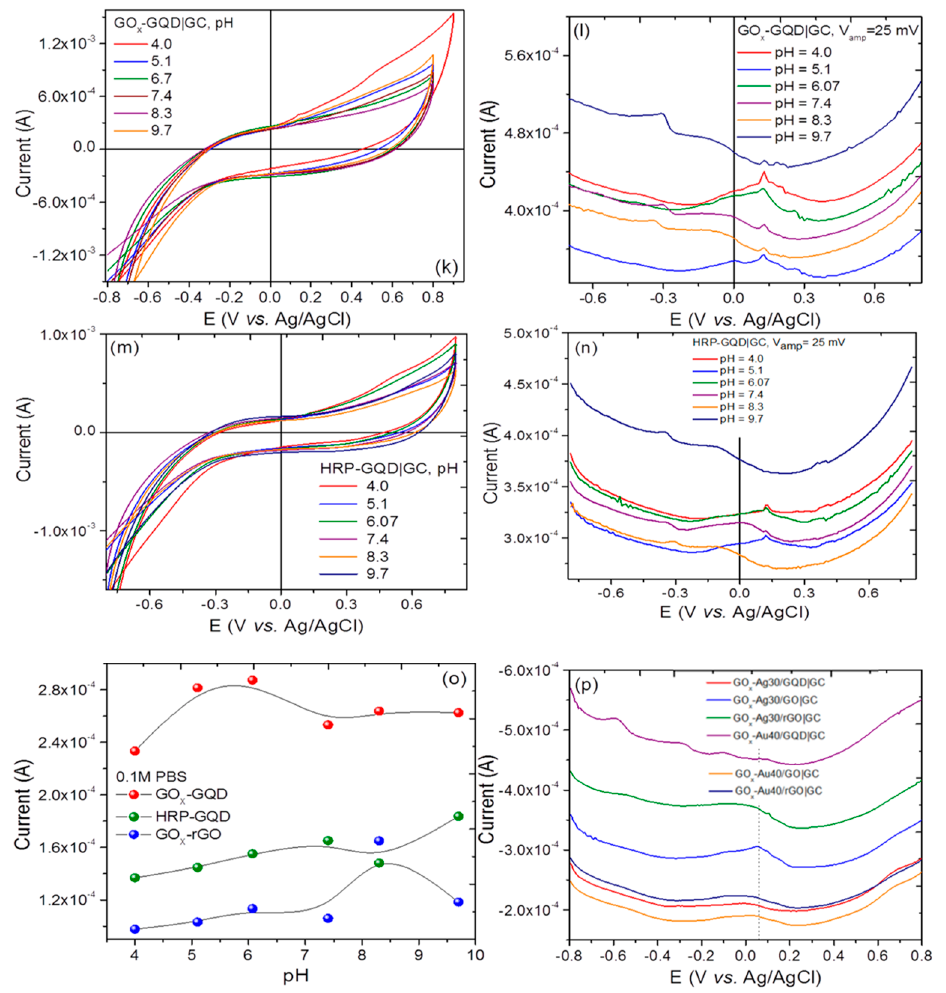
Figure 3. Cyclic voltammograms (CVs) of GQD immobilized on glassy carbon-GQD|GC with scan rate (10, 50 and 100 mV/s) in ( a ) in 0.1 M PBS (phosphate buffer solution) electrolyte pH 7.4 ( b ) in 0.1 M PBS electrolyte with 5 mM FcMeOH ( c ) variation of peak current with scan rate square root. ( d , f ) CV profiles and ( e , g , h ) variation of current with scan rate and square root scan rate (5, 10, 20, 50,100, 200, 300, 400 and 500 mV/s) in 0.1 M PBS and at 10 mV/s with 40 µ M H 2 O 2 adsorbed on GQD|GC and GQD|GC, respectively. Also shown are ( i ) CV profiles and ( j ) variation of peak current with scan rate square root for native horseradish peroxidase (HRP) adsorbed on GQD|GC for comparison with GO x and ( k , m ) CV and ( l , n ) differential pulse voltammetry (DPV) profiles for GO x and HRP adsorbed on GQD|GC with different pH (4.0, 5.1, 6.07, 7.4, 8.3, 9.7) of PBS electrolyte and ( o ) variation of peak current for GO x , HRP adsorbed on GQD|GC and GO x on rGO|GC substrates. ( p ) DPV profiles for GO x adsorbed on Ag30/(GQD, GO, rGO)|GC and Au40/(GQD, GO, rGO)|GC. All of the potentials are with respect to Ag/AgCl reference electrode for CV profiles and with varying pH they are measured at 20 mV s − 1 scan rate